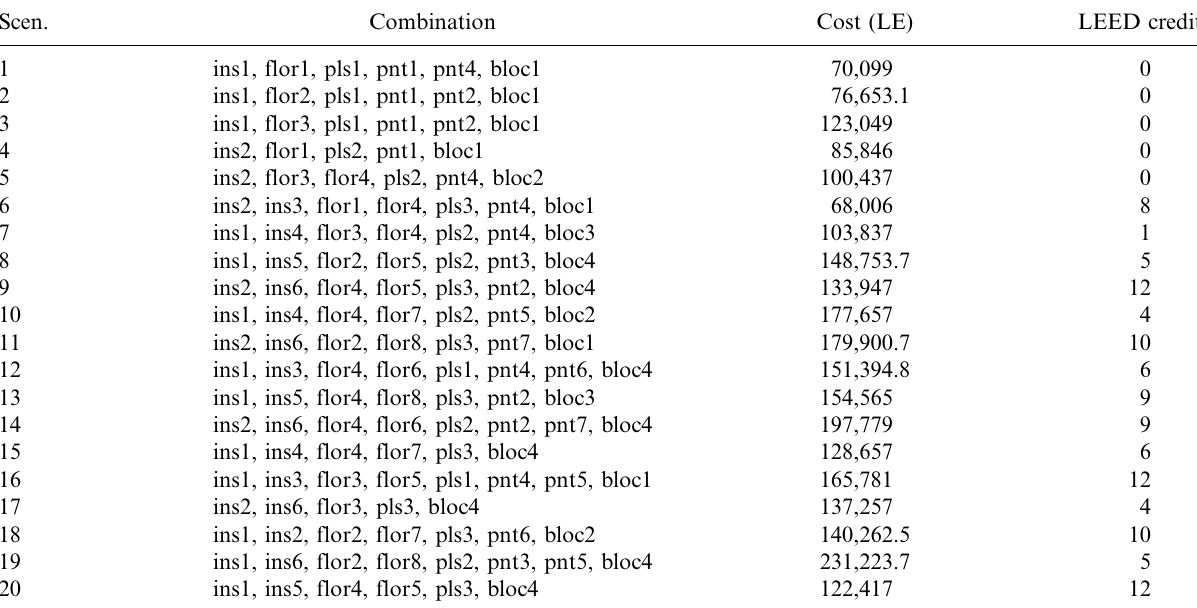
Table 3. Costs and LEED credits for all scenarios Scen.